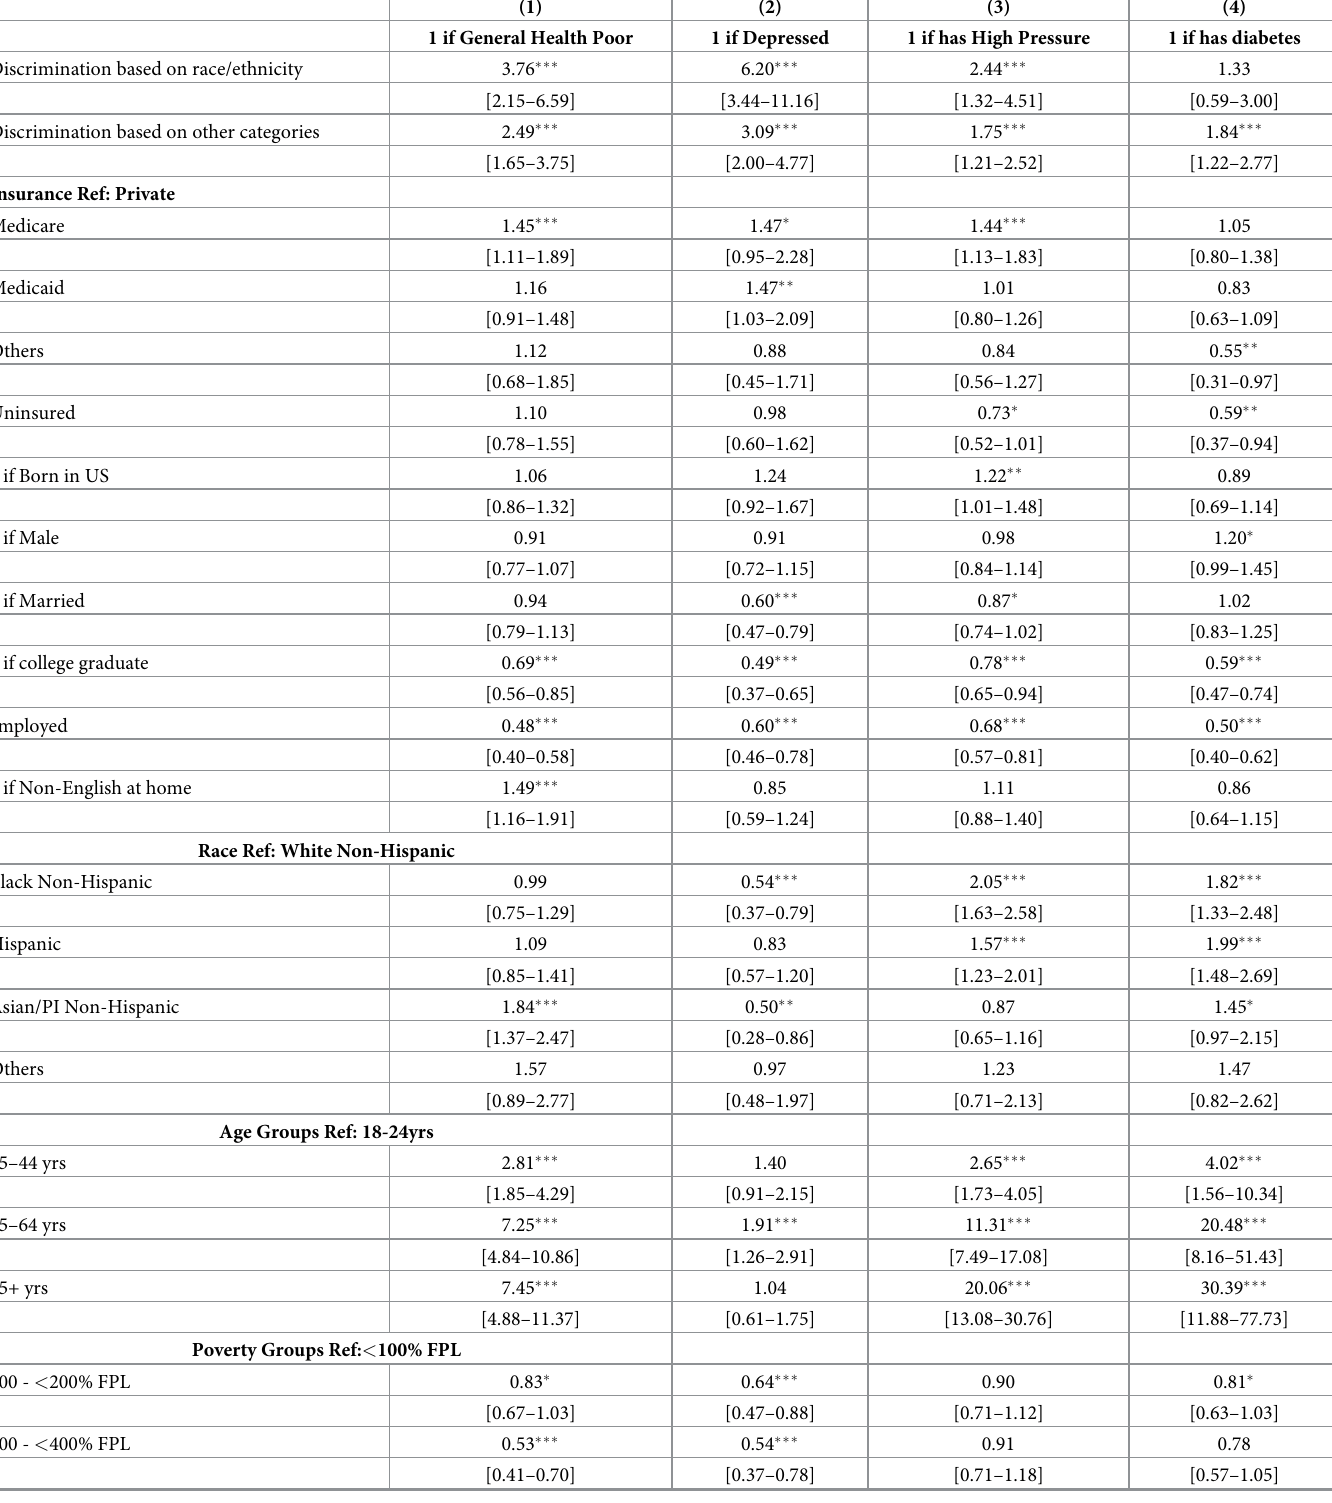
Table 3. Association between health outcomes and types of discrimination: 2016 NYC Community Health